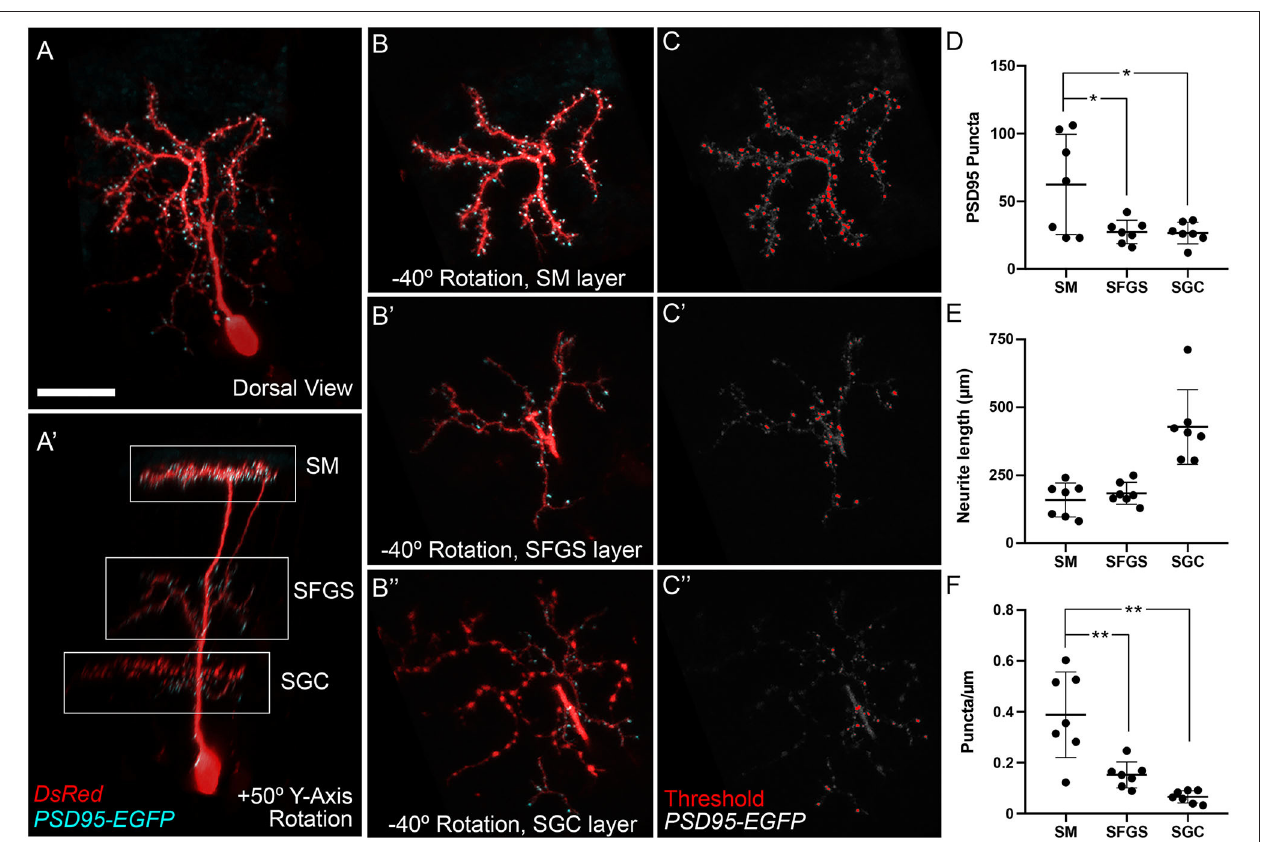
FIGURE 4 | PSD95-positive post-synaptic specializations in PyrN dendrites. (A) Maximum projection of PSD95-EGFP and DsRed expression in an isolated id2b:gal4 positive PyrN. Note discrete enrichments of PSD95-EGFP relative to cytosolic DsRed label. (A ′ ) + 50 ◦ Y-axis rotated view of image volume in (A) . SM, SFGS, and SGC dendritic portions are indicated by boxed regions. Note presence of PSD95-EGFP puncta in SM, SFGS, and SGC layer dendrites. (B) − 40 ◦ Y-axis rotated views of isolated subvolumes from boxed regions in (A ′ ) showing PSD95-EGFP and DsRed expression in the SM, SFGS, and SGC dendrites. (C) Threshold images of PSD95-EGFP channel in rotated subvolumes in (B) as an example of threshold values used for automated particle analysis (puncta counting). (D–F) Quantification of PSD95-EGFP puncta number, neurite length, and puncta density for SM, SFGS, and SGC dendrite subregions in 7 fully reconstructed PyrNs obtained from 7 larvae. Scale bar: 20 µ m in (A) and 15 µ m in (B,C) . * p < 0.05; ** p < 0.001; ANOVA with Tukey’s post-hoc